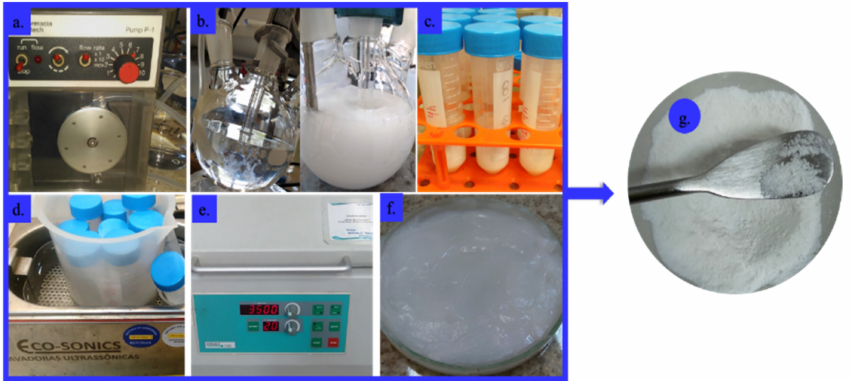
Figure 6. Graphical summary of the synthesis procedure of calcium-polyphosphate (CaPP) particles employing the coprecipitation method: ( a ) flow pump; ( b ) controlled addition of CaCl 2 · 2H 2 O solution (1 mL/min; pH = 10) into the NaPP solution; ( c ) After 4 h of stirring, distribution of the crude product in falcon tubes; ( d ) washing of CaPP (twice with water and twice with ethanol); ( e ) Centrifugation after every wash; ( f ) CaPP slurry obtained; ( g ) CaPP dried fine